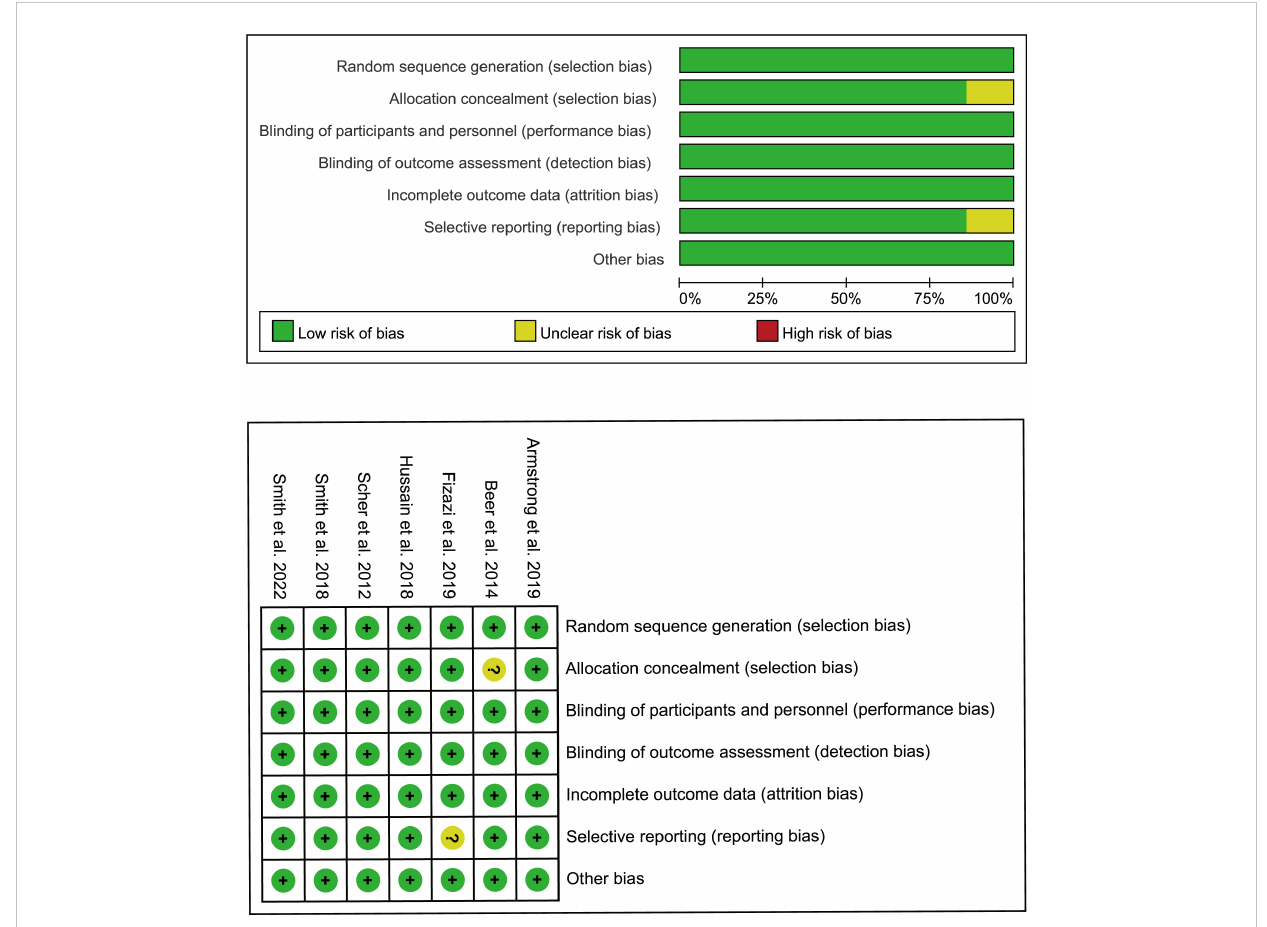
FIGURE 2 Bias risk assessment criteria for randomized controlled trials based on the Cochrane Collaborative